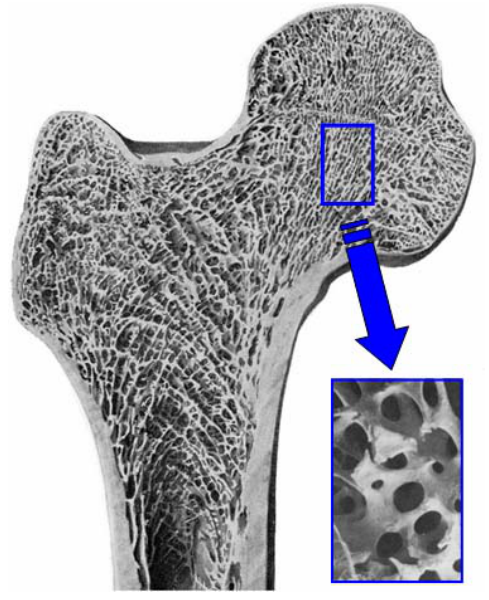
Figure 10. Example of cancellous bone. Cancellous bone has fully interconnected porous